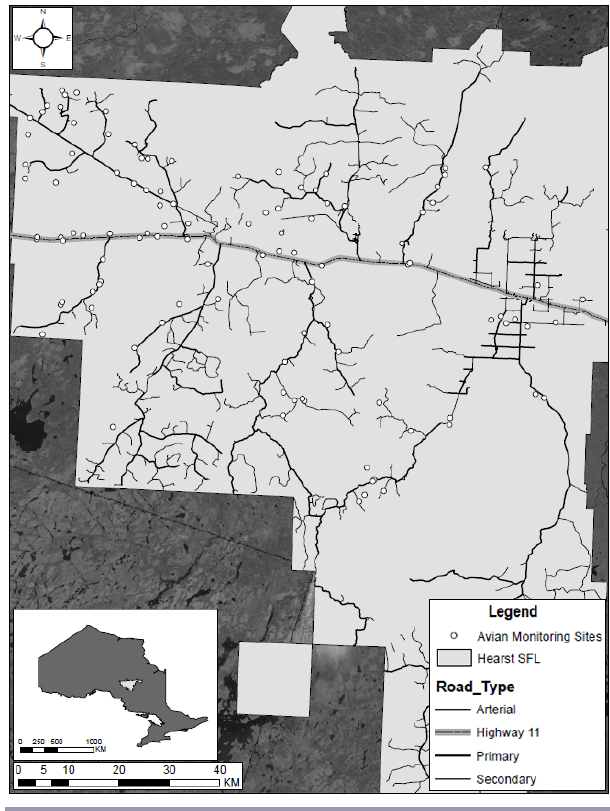
Fig. 1 . Location of sampling sites where automated recording units were deployed to detect forest bird species in 2013 and 2014 at 108 stations in Hearst Forest Sustainable Forest License, Ontario, Canada.